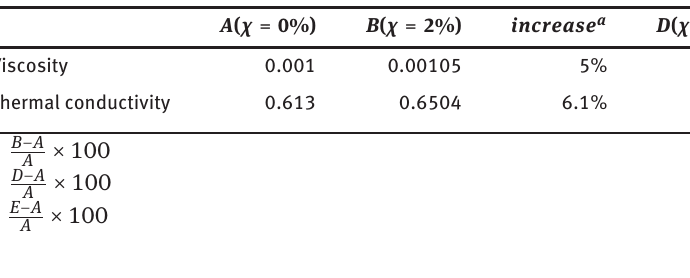
Table 4: The values of the properties of the nanofluid for different solid volume